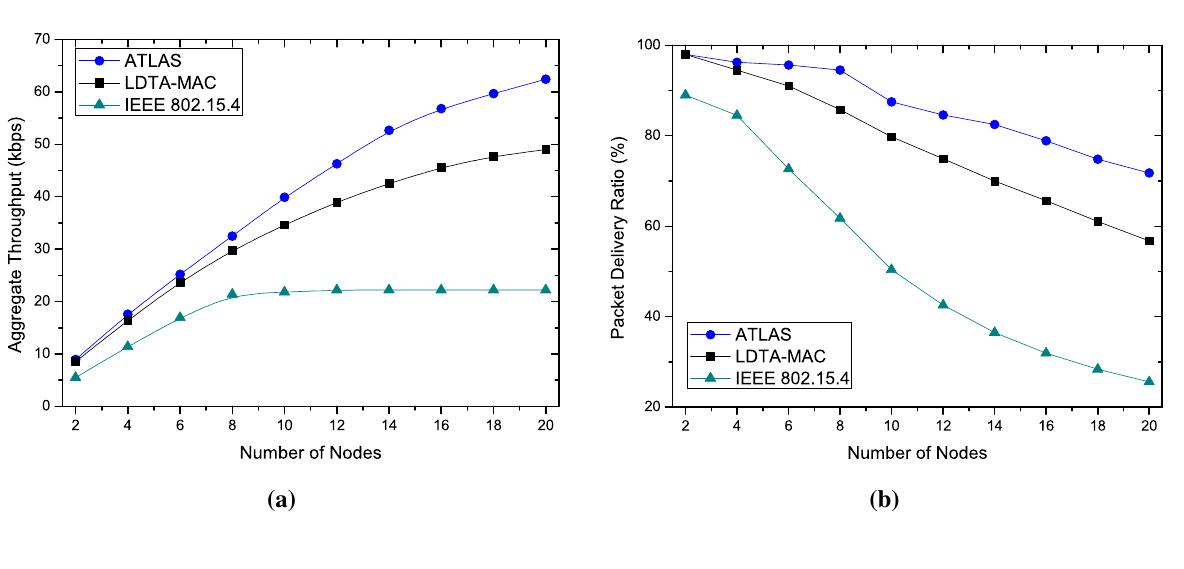
Figure 8. Data fidelity over different number of nodes: (a) Aggregate throughput; and (b) Packet delivery